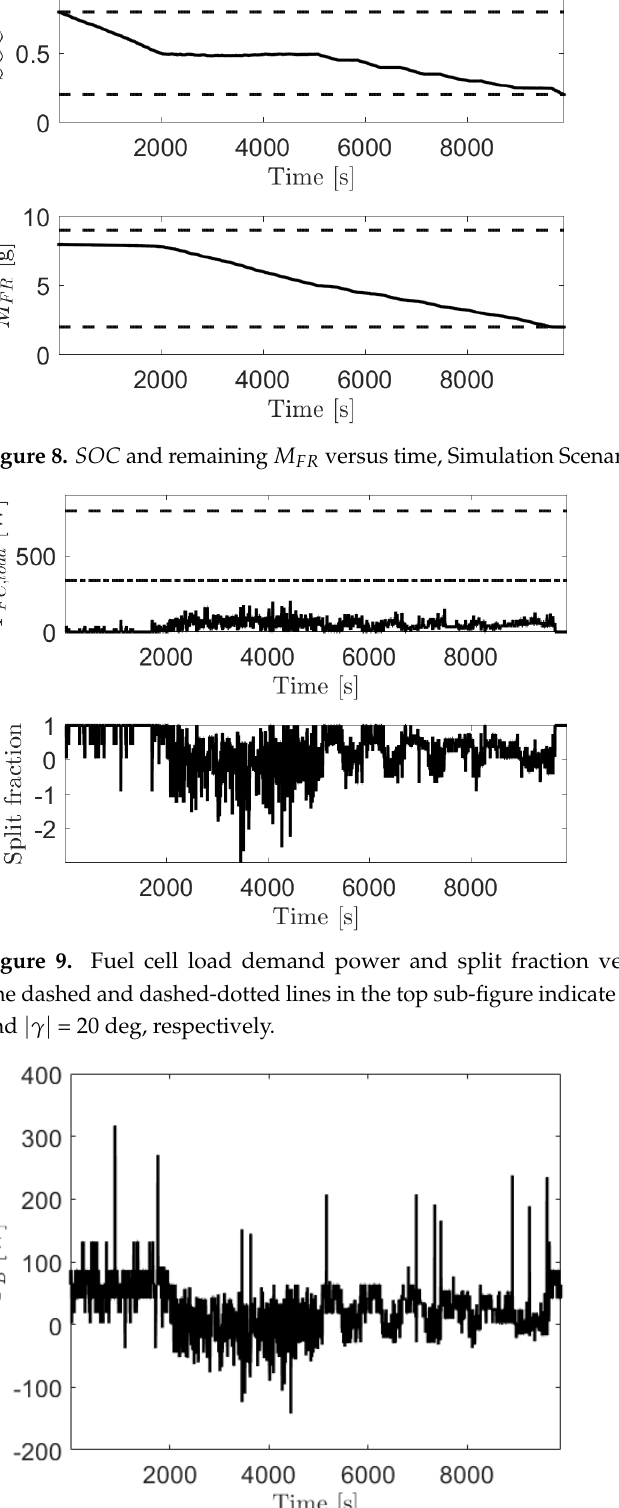
Figure 10. Battery power, Simulation Scenario